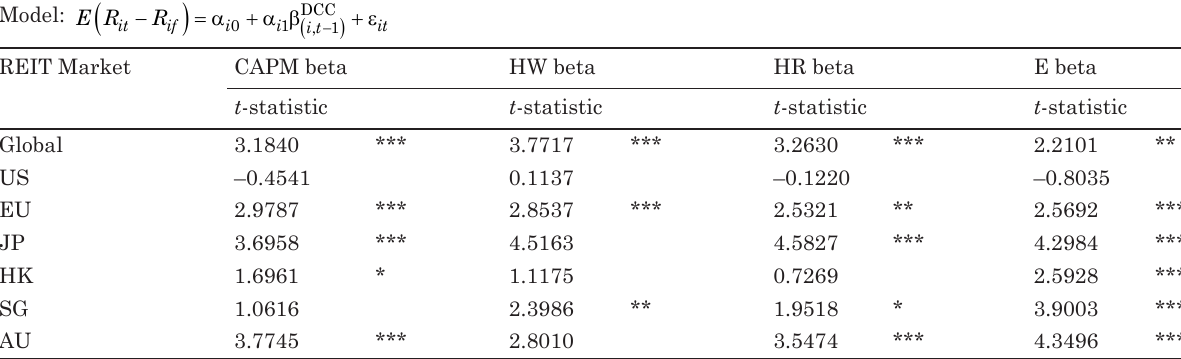
Table 9. The relationship between the DCC betas and the expected REIT return Model: